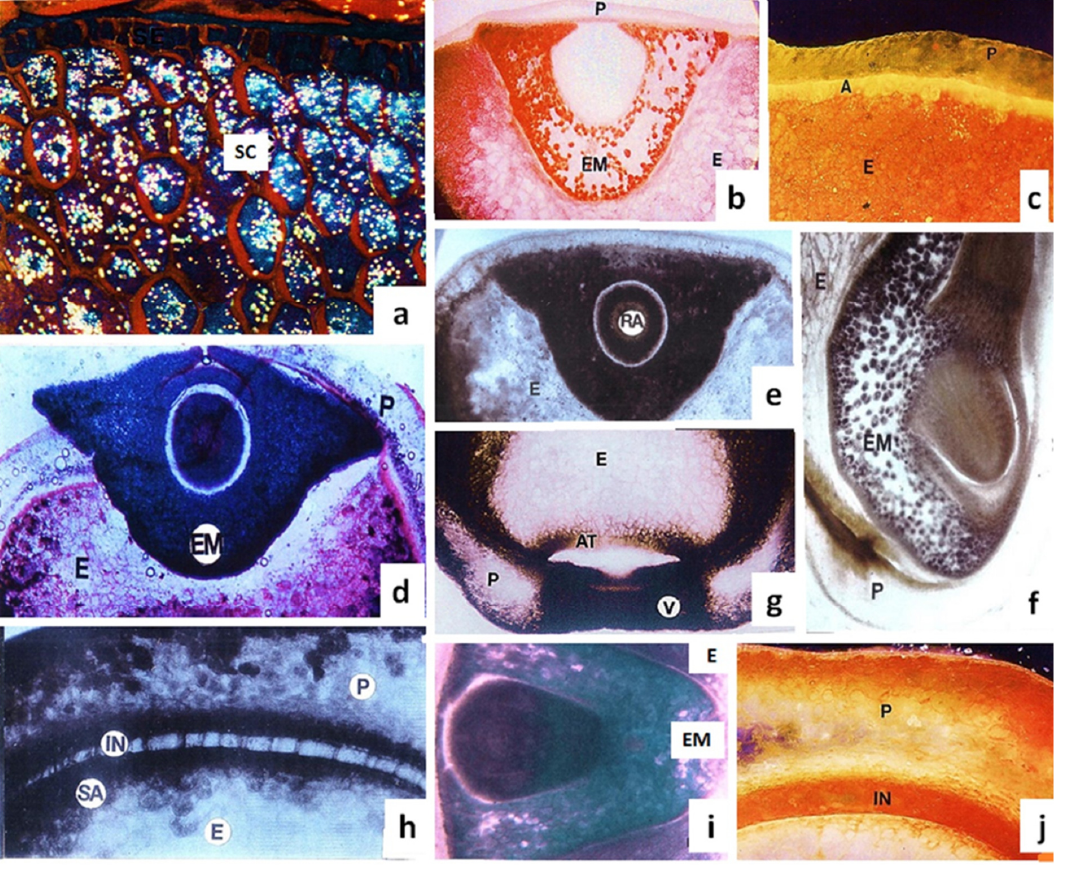
Figure 6. Phytin, minerals, tannin, enzyme activity in sorghum caryopsis (a) Microtome section of mature caryopsis stained with Safranin and Fast Green. Between crossed polarizers aleurone grains appear bright in cells of the scutellum. 200x. (b) Free-hand T.S. of mature caryopsis stained with Alizarin Red. Phytin appears red in embryonal cells. 30x. (c) Free-hand T.S. of mature caryopsis stained with Alizarin Red, excited with blue light, revealing phytin granules in the aleurone cells. 160x. (d) Distribution of magnesium, localized by Magneson Reagent in sorghum cv. IS-18161. 40x. (e) Abundant potassium in the embryo, localized by Sodium Cobalitinitrite Reagent. 40x. (f) L.S of caryopsis showing the distribution of magnesium in embryo region localized by Magneson Reagent. 40x. (g) High activity of esterase is noticed in vascular region, chalazal complex, endosperm transfer cells, outer endosperm layers and pericarp tissue in 10-day-old caryopsis. 50x. (h) Esterase activity compartmentalized in outer and inner pericarp and aleurone and subaleurone layers, but not in the inner integument. 190x. (i) Localization of iron with Potassium Ferro cyanide-HCL reagent in embryo region. 50x. (j) Caryopsis of cv. ‘Framida’ section 10 DAF and stained with Nitroso reaction revealing presence of tannin in outer pericarp and inner integument layers.